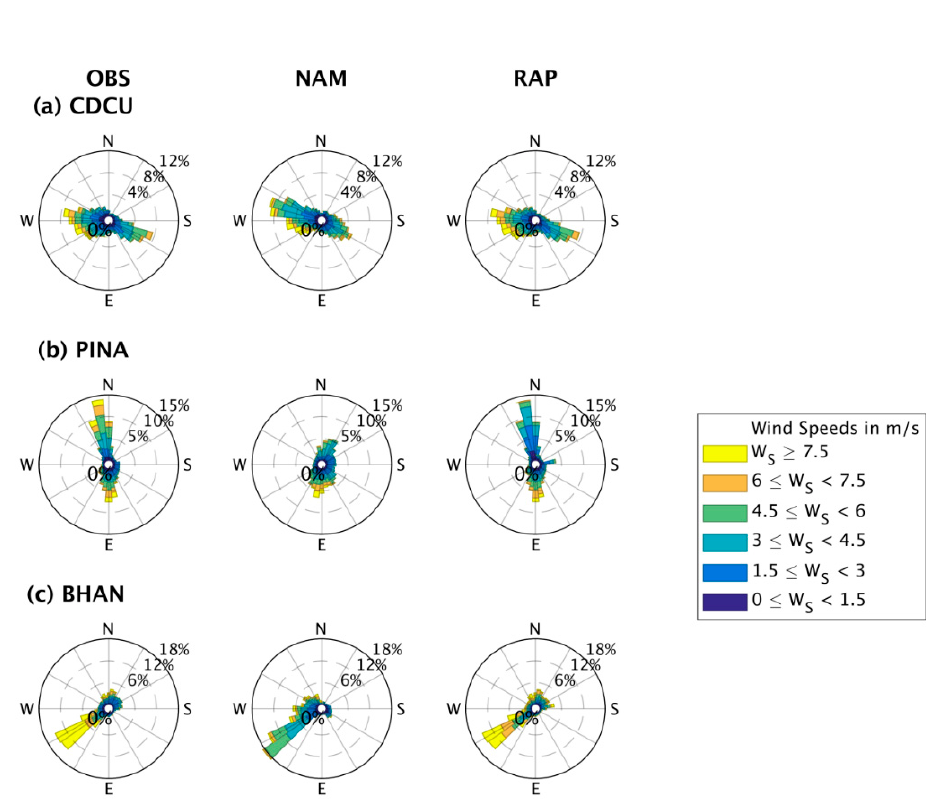
Figure 11. 2013 forecast and observed wind rose of hourly surface wind for ( a ) CDCU; ( b ) PINA; and ( c ) BHAN stations. For illustrative purposes only a good (1.1 < σ < 0.9), regular (0.9 ≤ σ < 0.75) and low wind predictability ( σ ≤ 0.75) station, according to the Taylor diagrams (Figure 8), is shown.